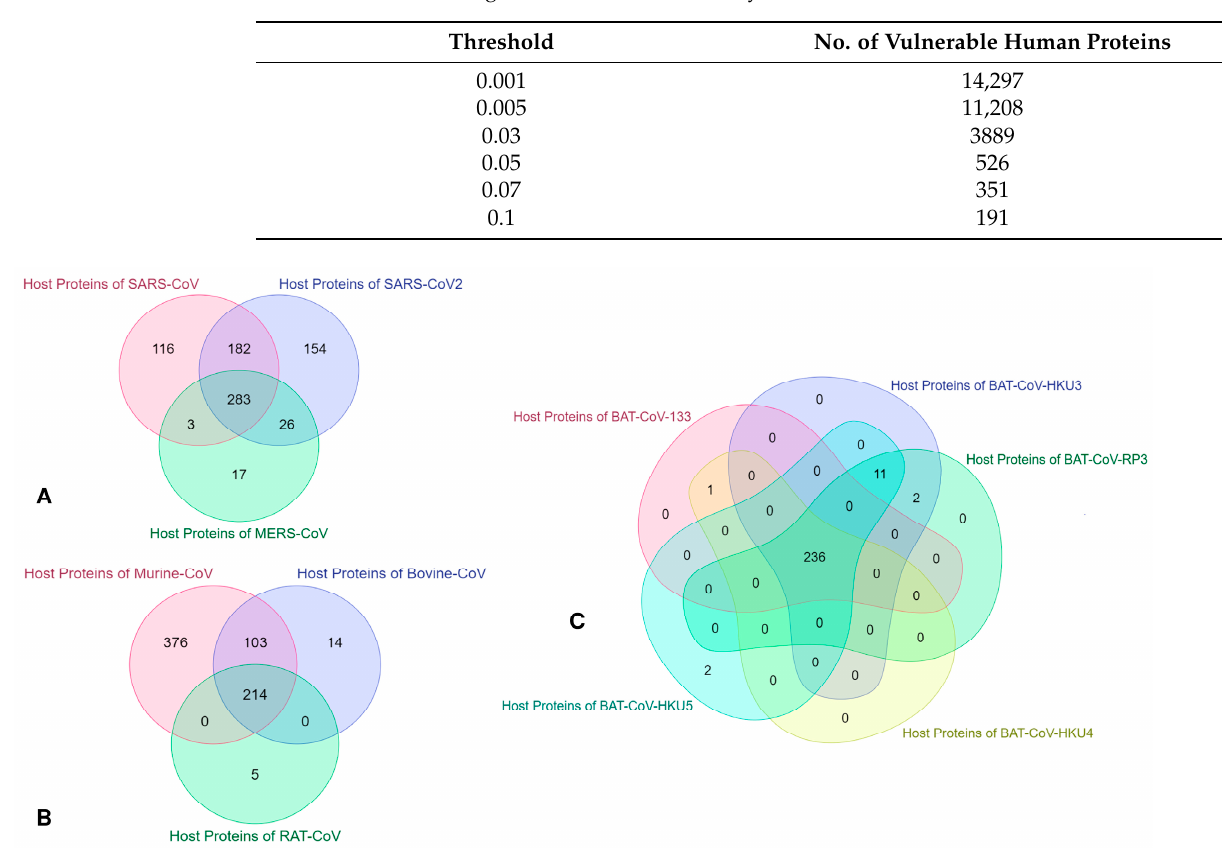
Figure 2. Venn diagram of the number of vulnerable host proteins obtained from host–pathogen interaction for all selected coronavirus organisms at 0.1 fuzzy threshold value. ( A ). The intersection of host protein identified from SARS-CoV-2, SARS-CoV, and MER-CoV. ( B ). Intersected host proteins from Murine-CoV, Bovine-CoV, and Rat Coronavirus. ( C ). Intersected host proteins of different viral organisms of Bat Coronavirus.